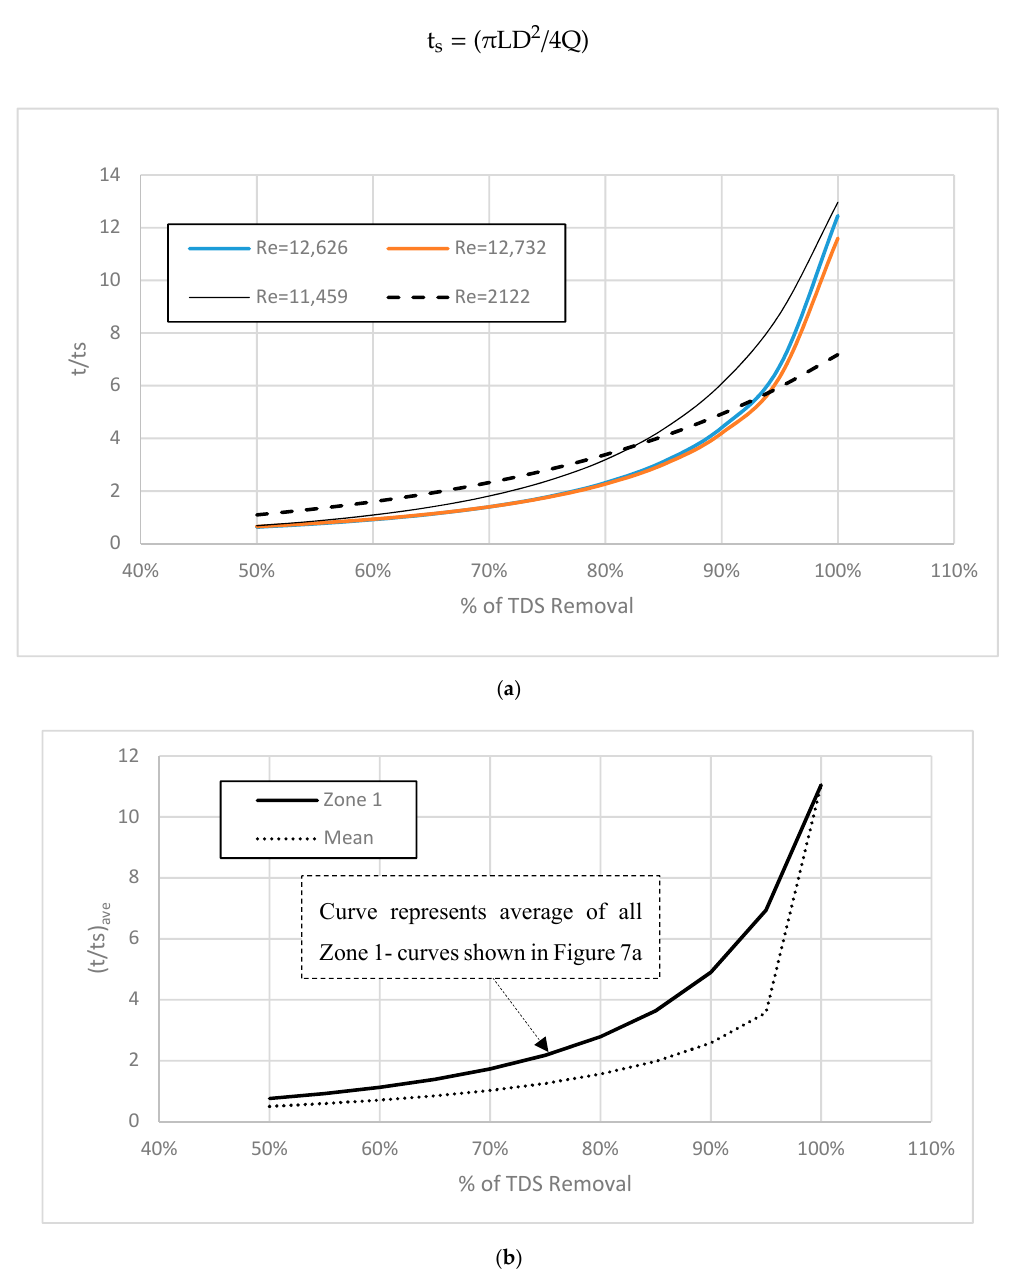
Figure 6. ( a ) Effect of Re and Purging Flow Rate on Time of TDS Removal Ratio (Zone 1, Xp/D = 3) and ( b ) average Time of Removal Ratio for Achieving a Specified % of TDS Removal (Xp/D = 3).